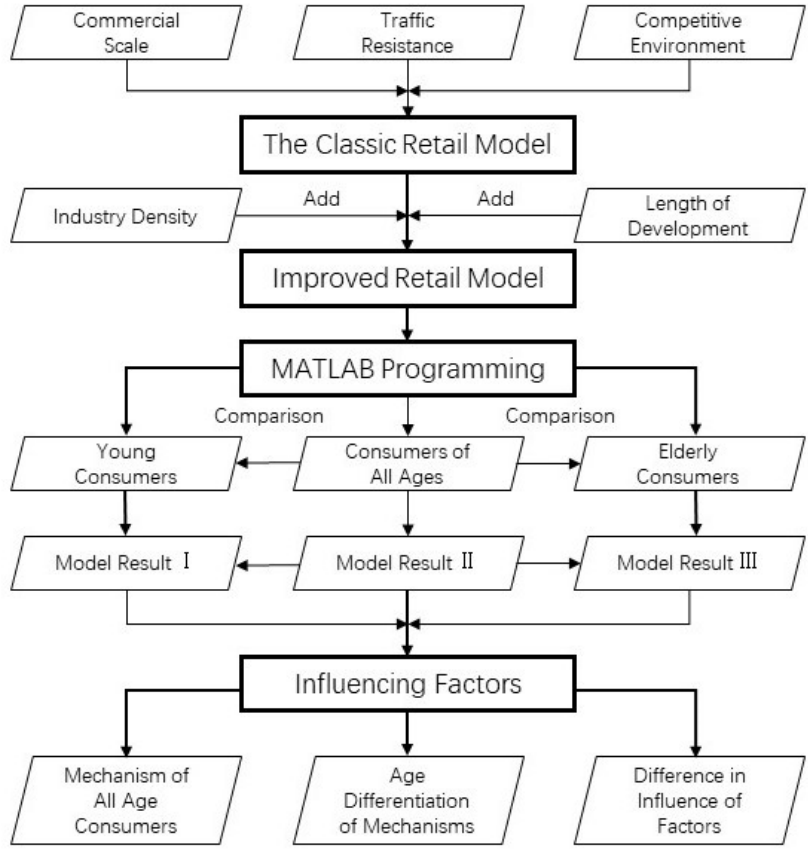
Figure 1. Analysis framework.